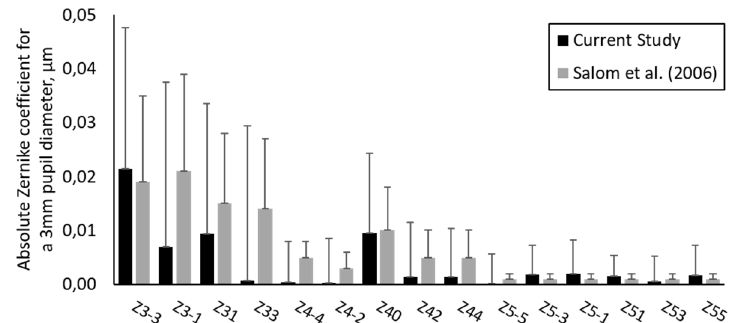
Figure 4. Comparison of the absolute Zernike coefficient (µm) for the higher order aberrations until fifth order from the current study to normal human subjects for a 3 mm pupil diameter (data from Salmon et al. [34]).